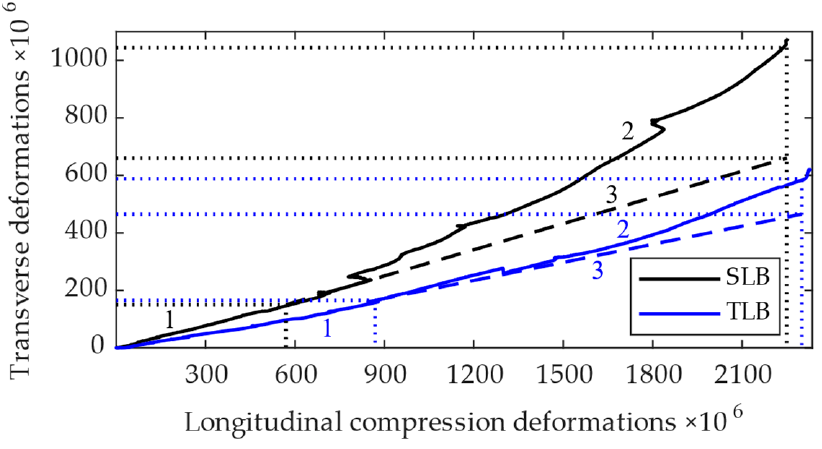
Figure 7. Dependence between transverse and longitudinal deformations. Line 1: linear relationship; line 2: non-linear relationship; line 3: conditionally shown extension of linear elastic transverse deformations.